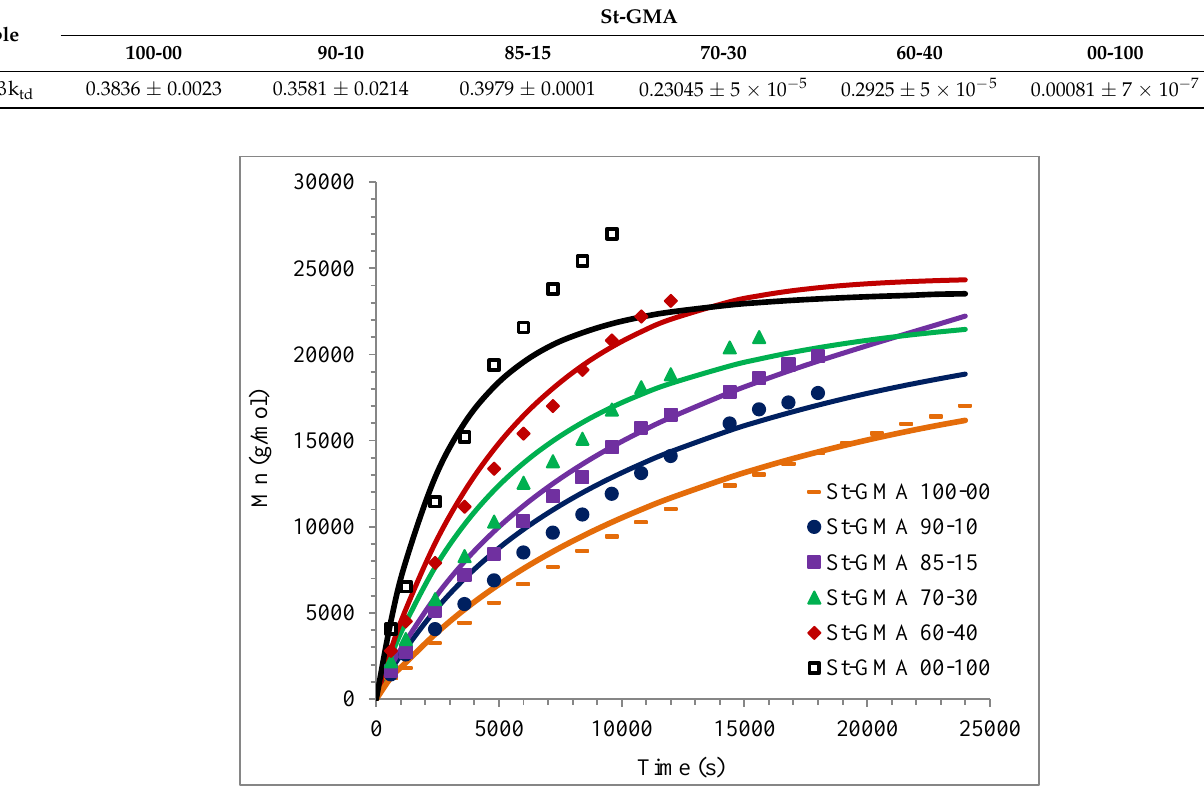
Figure 7. Profiles of M n versus time for St-GMA samples. Symbols and solid lines correspond to experimental and calculated profiles, respectively.